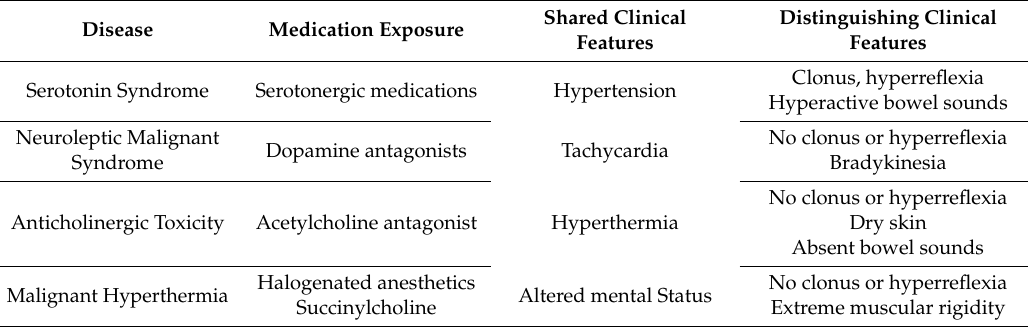
Table adapted from